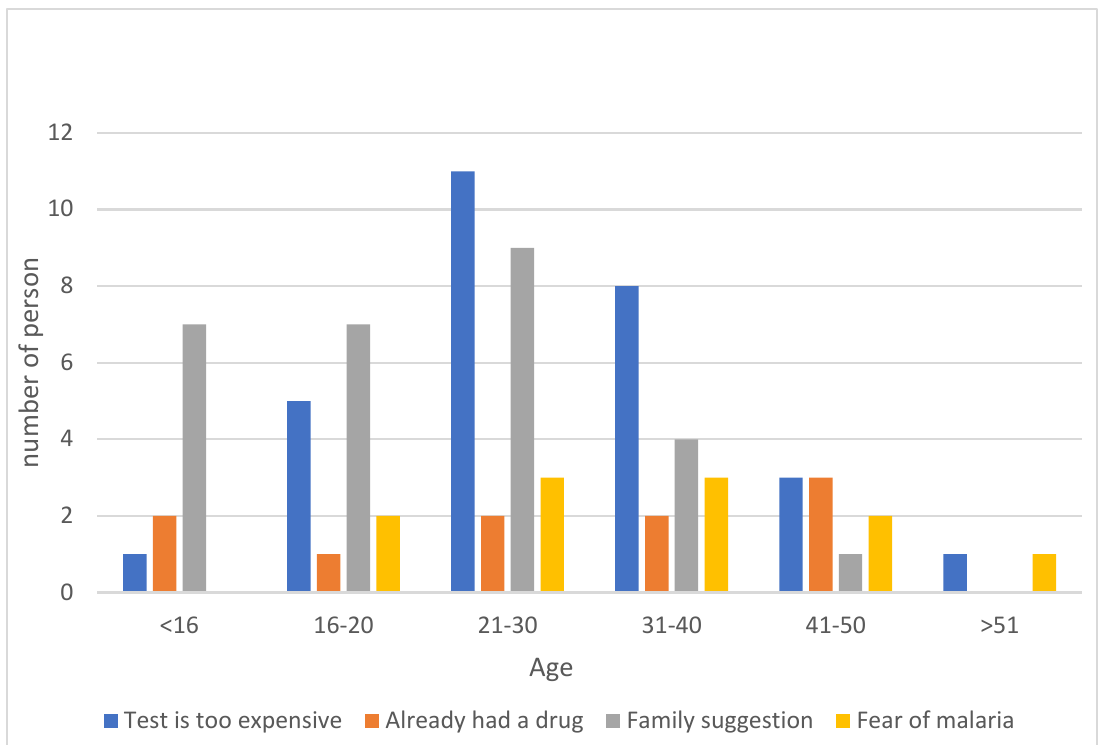
Figure 8. Results of responses to the question of why the respondent did not take a rapid diagnostic test for malaria.